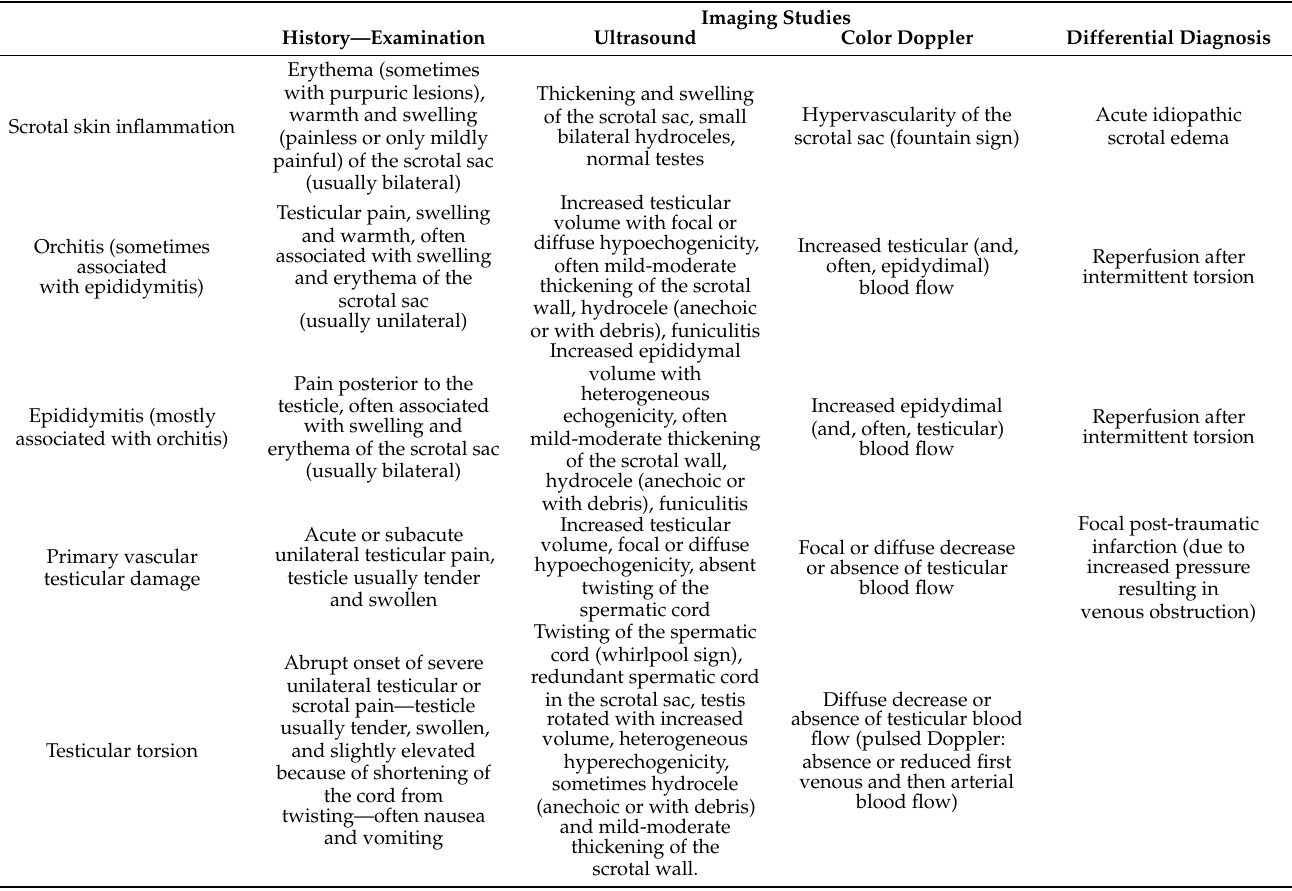
Table 5. Henoch–Schönlein syndrome with scrotal involvement. History, physical examination, imaging studies, and differential